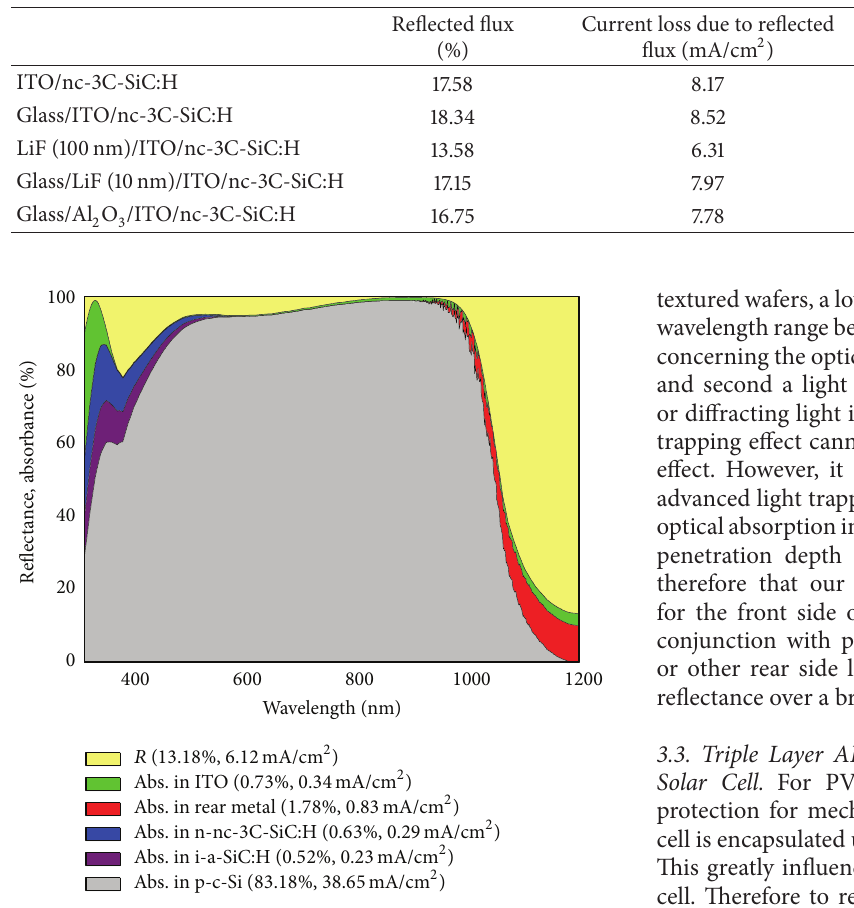
Figure 6: The absorbance at each layer of SHJ solar cell with nc-3C- SiC:H emitter, ITO, and LiF dielectric AR